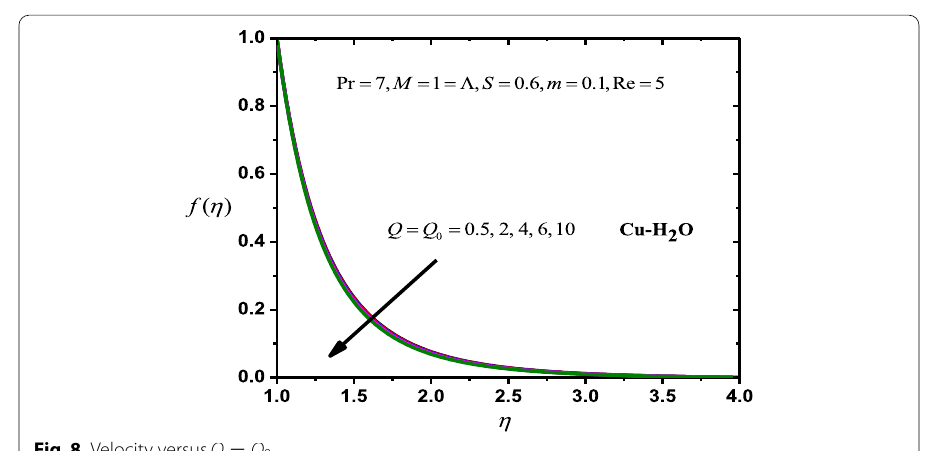
Fig. 8 Velocity versus Q